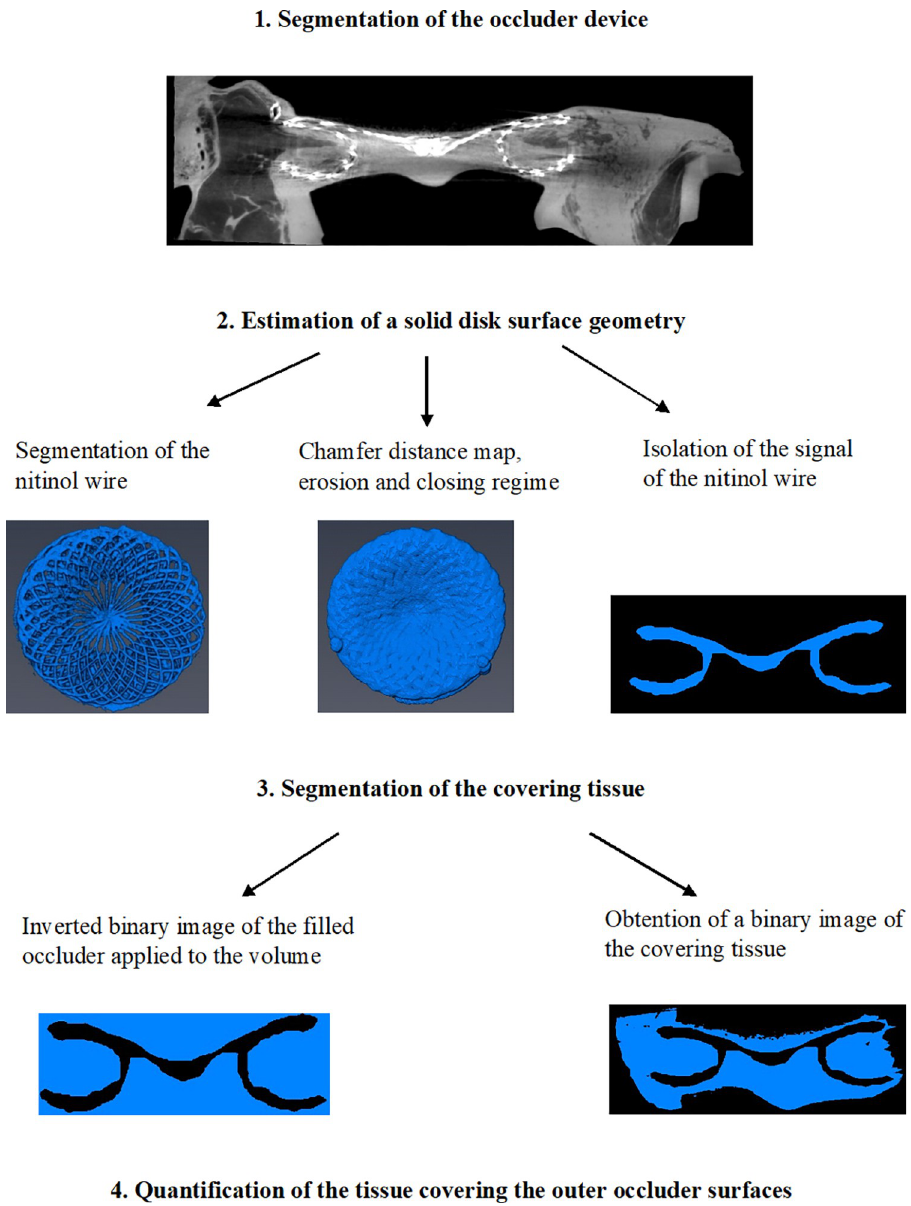
Fig 3. Pipeline of the 3D